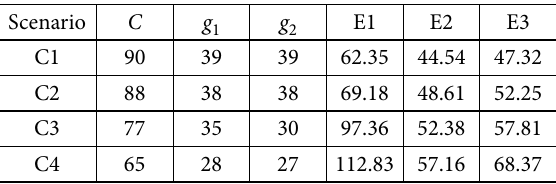
Table 4. The signal-timing plans and collected evaluation indexes